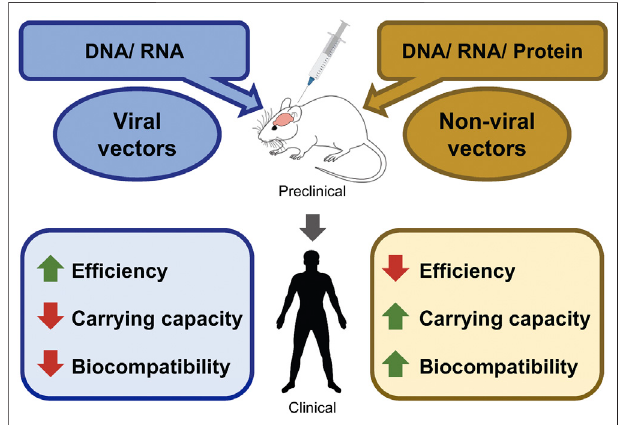
FIGURE 1 | Perspectives of advantages/disadvantages of viral-, and non-viral gene delivery methods. Schematic diagram shows the possible packaging materials of viral and non-viral vectors. Packaged vectors can be tested in the preclinical models of various neurological disorders. Followed by successful preclinical trials, human clinical trials can be conducted. The advantages and the disadvantages of each vector are marked in green and red,